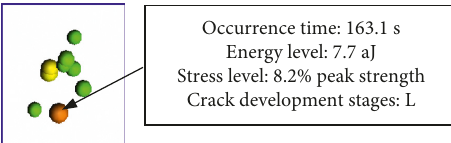
Figure 11: The spatial distribution of the AE events in the area outlined by solid lines in Figure 9(b) at 163.1s.